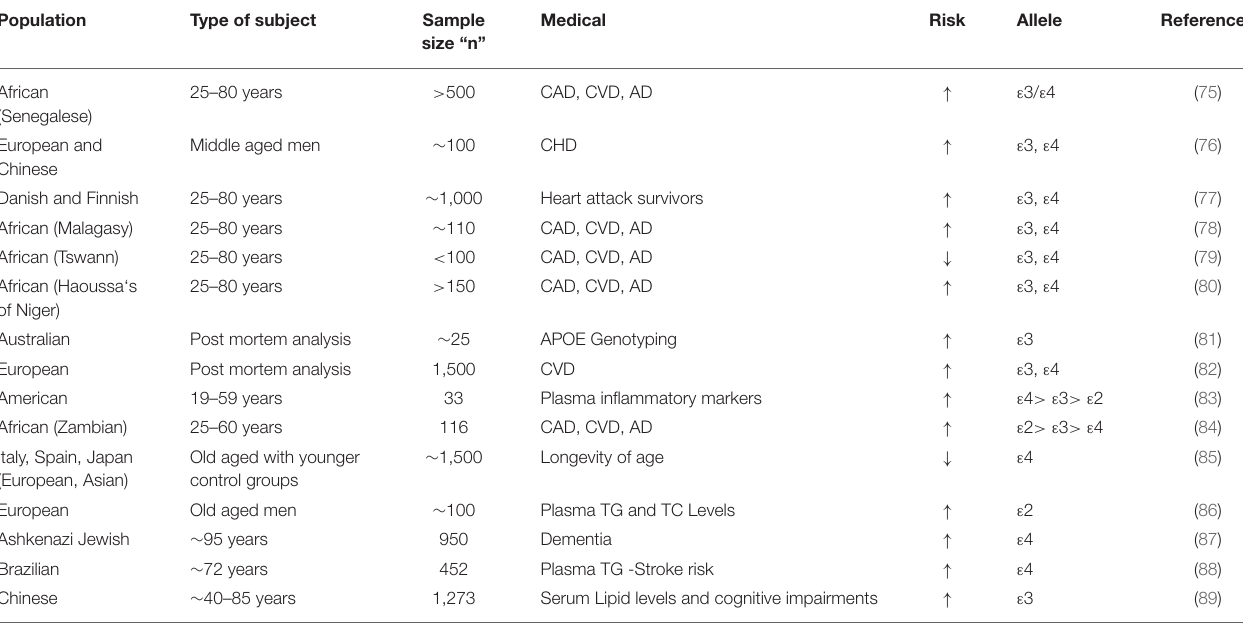
TABLE 4 | The APO ε isoforms related genetic studies depicting the risks of various medical